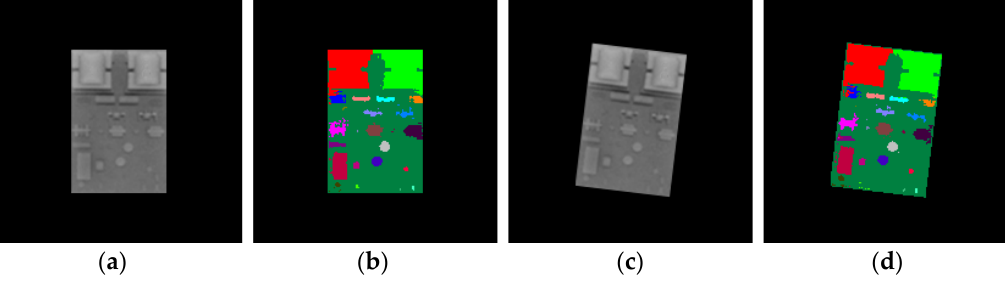
Figure 9. Real depth images and the corresponding pixel classification images. ( a , c ) Real depth images for test. ( b , d ) The corresponding pixel classification images generated by the trained random forest pixel classifier.